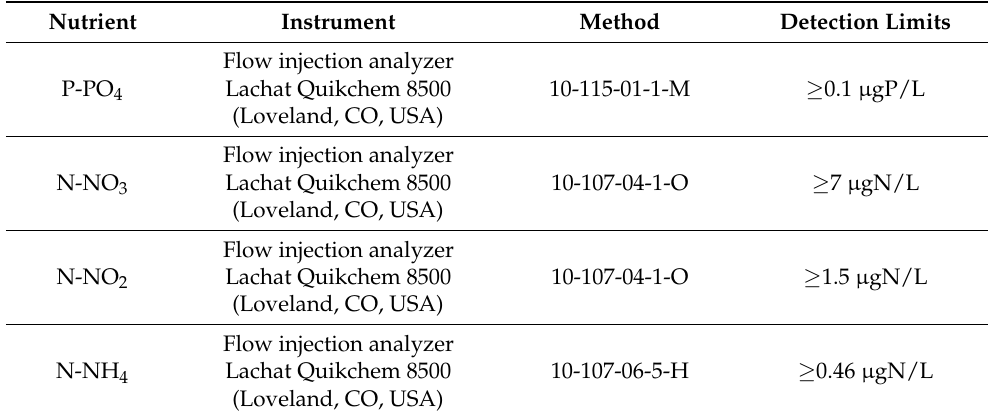
Table 1. Nutrient analysis methods.